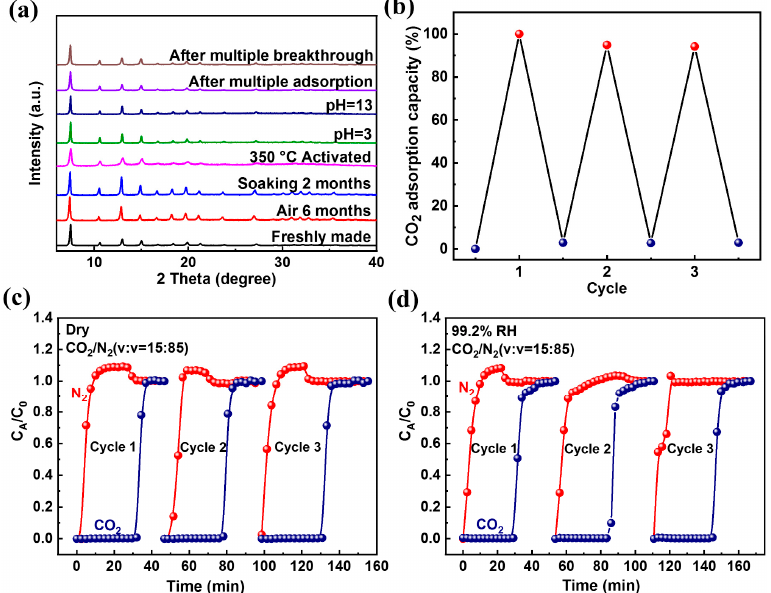
Figure 4. ( a ) Corresponding PXRD patterns to show the maintained structure of ZIF-94 under different conditions. ( b ) Cycling adsorption isotherms for CO 2 at 298 K and 1 bar. Cycling breakthrough experiments on CO 2 /N 2 mixture (15/85, v / v ) under two humidity conditions: ( c ) dry gas and ( d ) wet gas (99.2% RH).